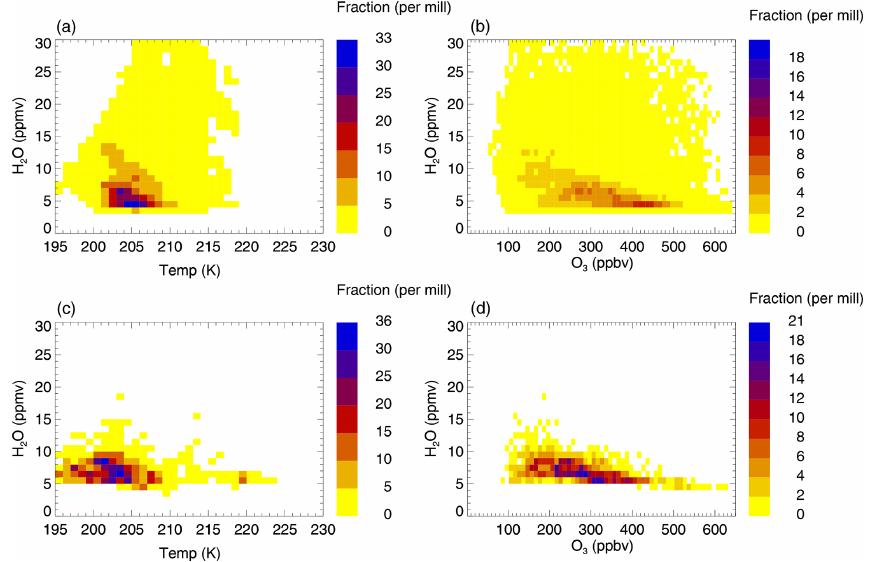
Figure 3. Comparison of the relative distribution of the occurrence frequency of data points in the GLENS mixing layer of case C2010 between stratospheric and tropospheric air masses (a, b) with measurements of the SEAC 4 RS aircraft campaign (c, d) . Panels (a) and (c) show the relative frequency distribution regarding H 2 O and temperature conditions and panels (b) and (d) regarding H 2 O and ozone mixing ratios. The relative frequency distribution is derived by calculating the number of data points found in a specific temperature and H 2 O bin (1K × 1ppmv H 2 O; a, c ) or ozone and H 2 O bin (10ppbv O 3 × 1ppmv H 2 O; b, d ) considering all H 2 O and temperature (ozone) ranges given in Table 2. The number of data points of each temperature–H 2 O (O 3 –H 2 O) bin is normalized by the total number of data points. The colour scheme marks these